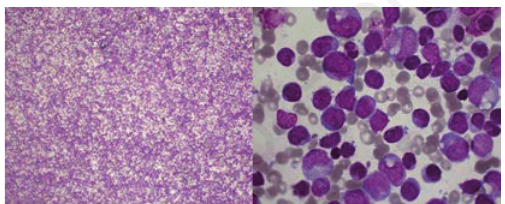
Figura 1. La valutazione morfologica dell’aspirato midollare ha consentito di rilevare un incremento della cellularità con iper- plasia della serie mielomonocitaria ed un’infiltrazione da parte di linfoblasti atipici, con citoplasma basofilo, nucleoli ben evi- denti, in misura del